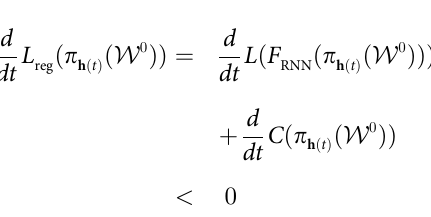
P . The norm of neural gradients, k g k , is shown over the course of training. J 2 ij ij ¼ J 2 . ij ij